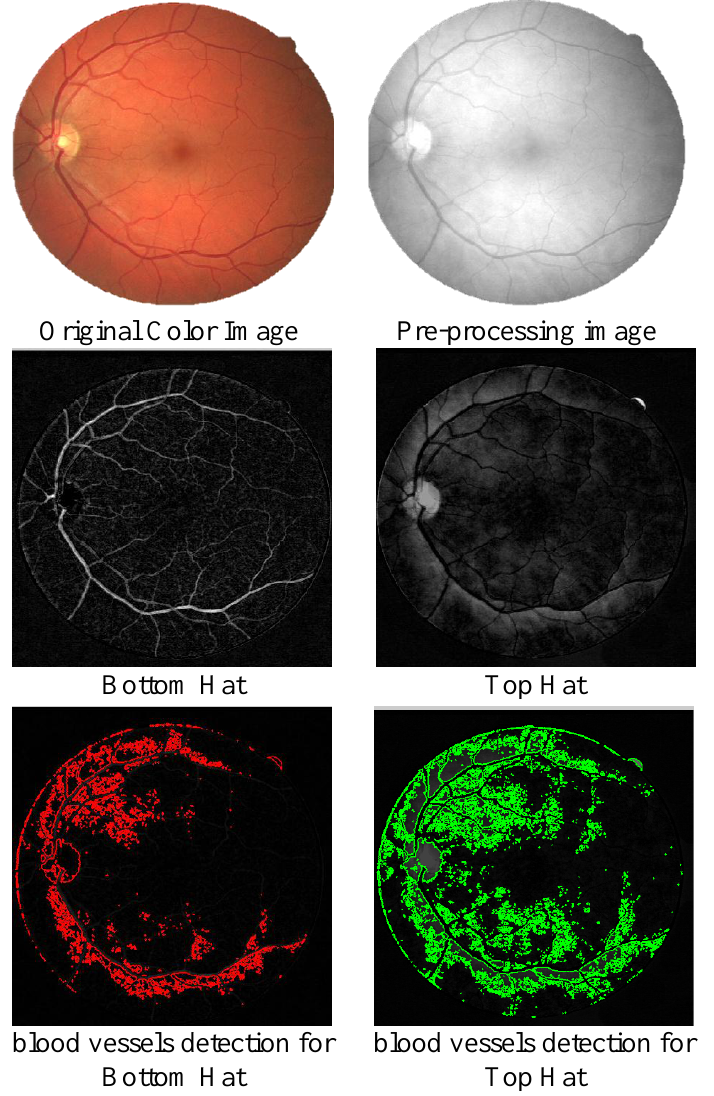
Fig.10: Retinal fundus images which contain blood vessels (abnormalities) that can be detected using simple morphological operations using top, bottom hat method (from